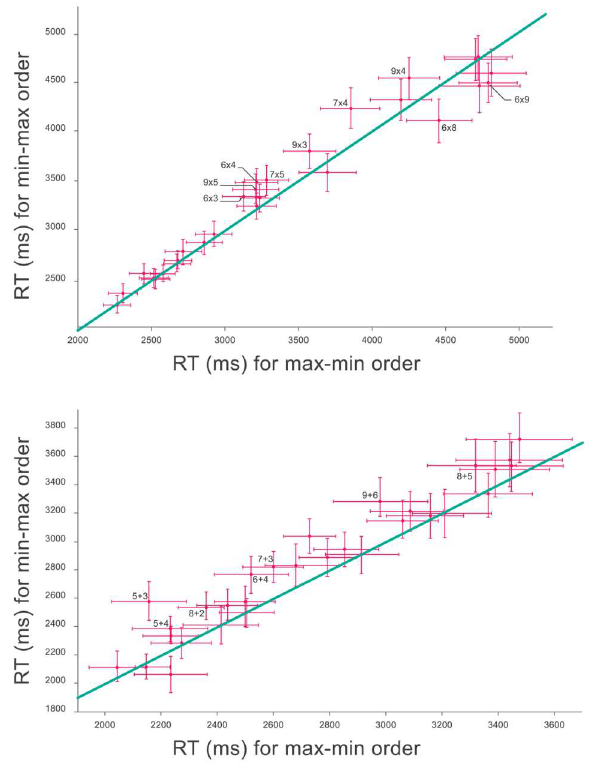
Fig 9. mean RTs and standard error for Op1 > Op2vs. the same for Op1 < Op2, for the times table (above) and additiontable (below). All but tie cases of the tables are shown, but just those in which the difference between both RTs at the two axes is significantare labeled;these are the points which standarderror bars do not cross the diagonal